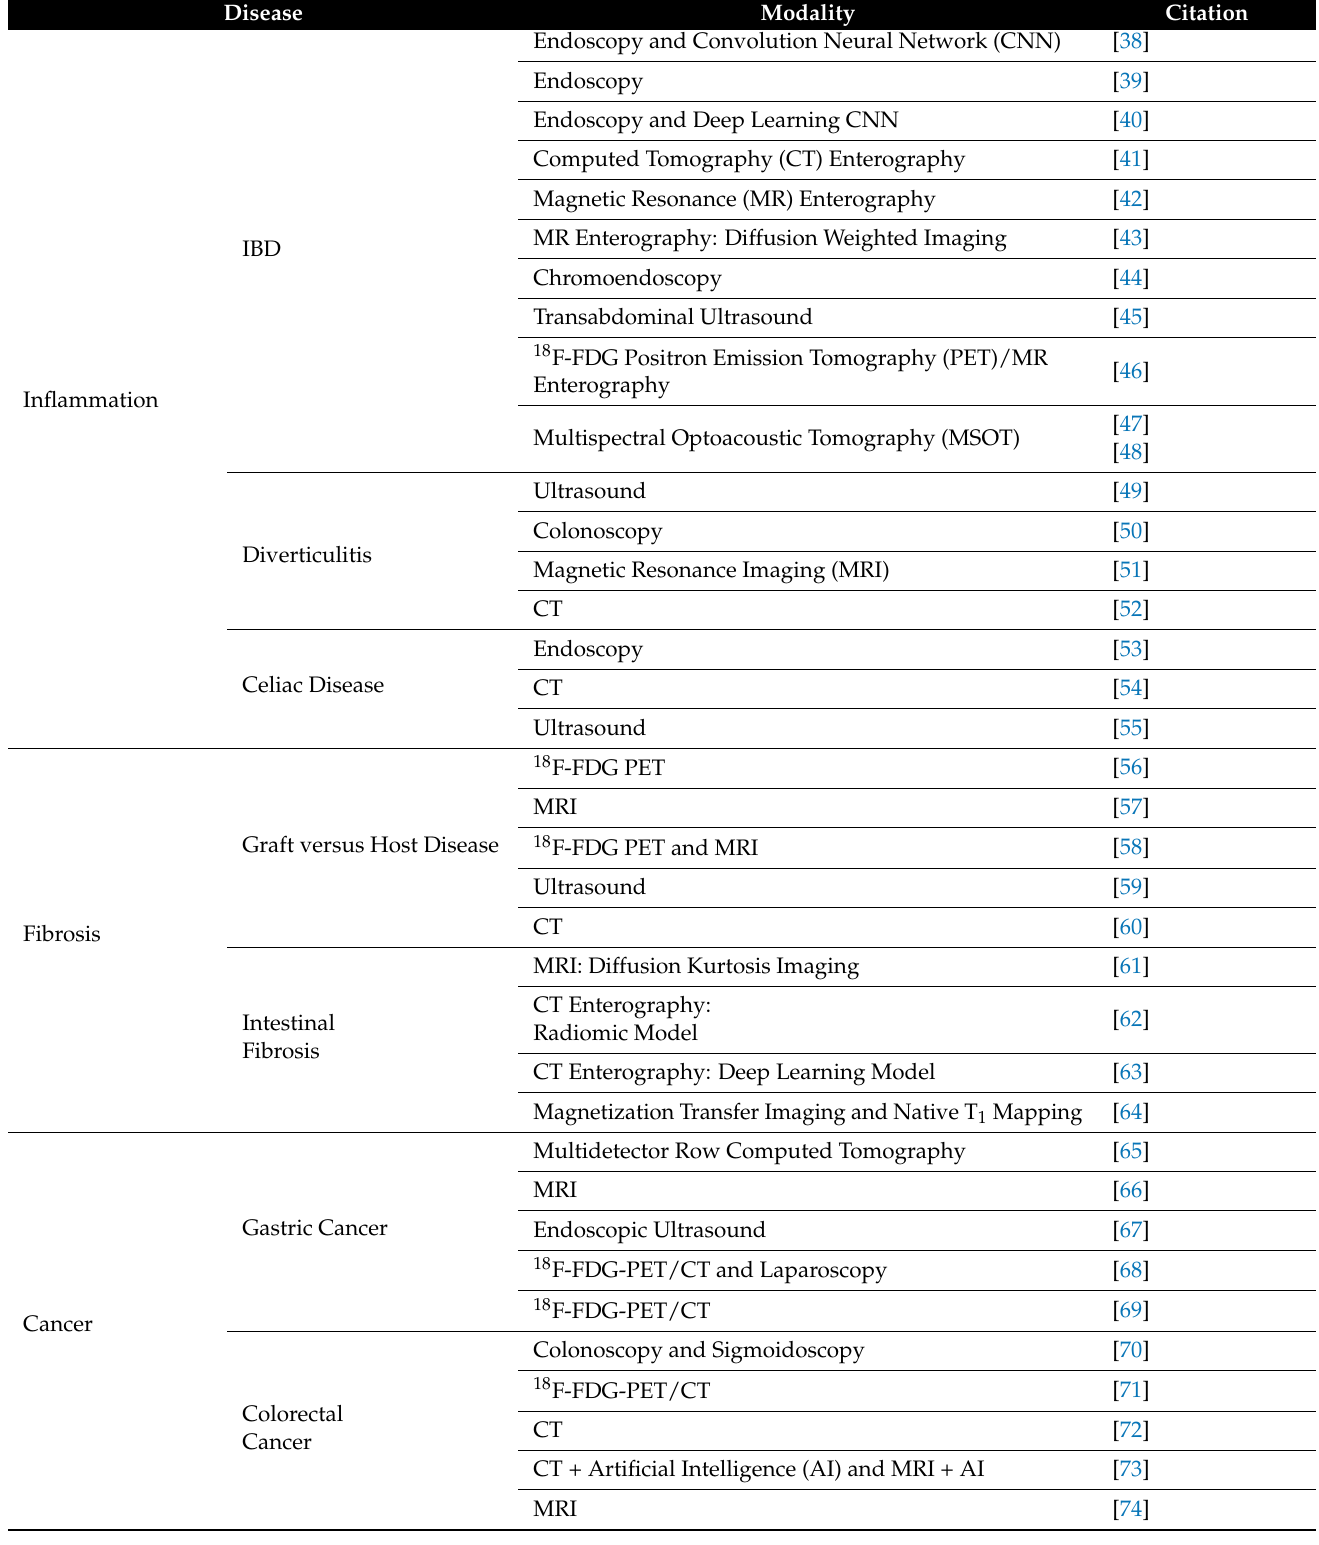
Table 1. Summary of pre-existing and newly developed imaging modalities for inflammation, fibrosis, and cancer in the GI